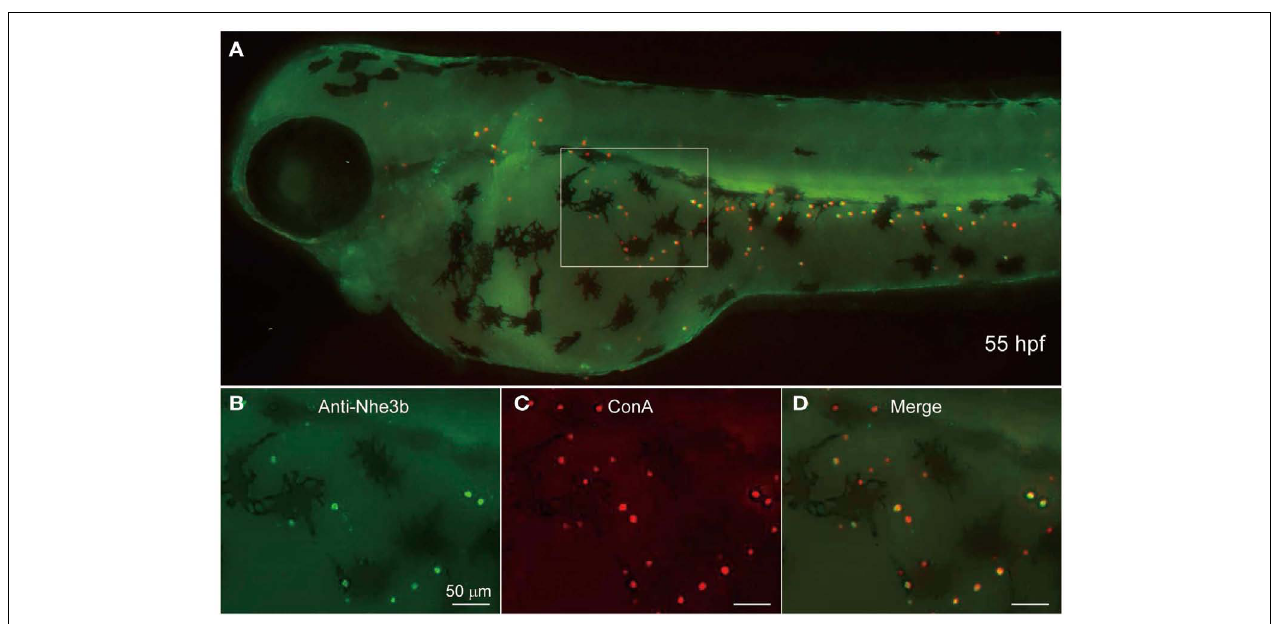
boxed area in (A) . Green signals for Nhe3b were relatively weak and therefore enhanced before merging with red signals for ConA. hpf, hours